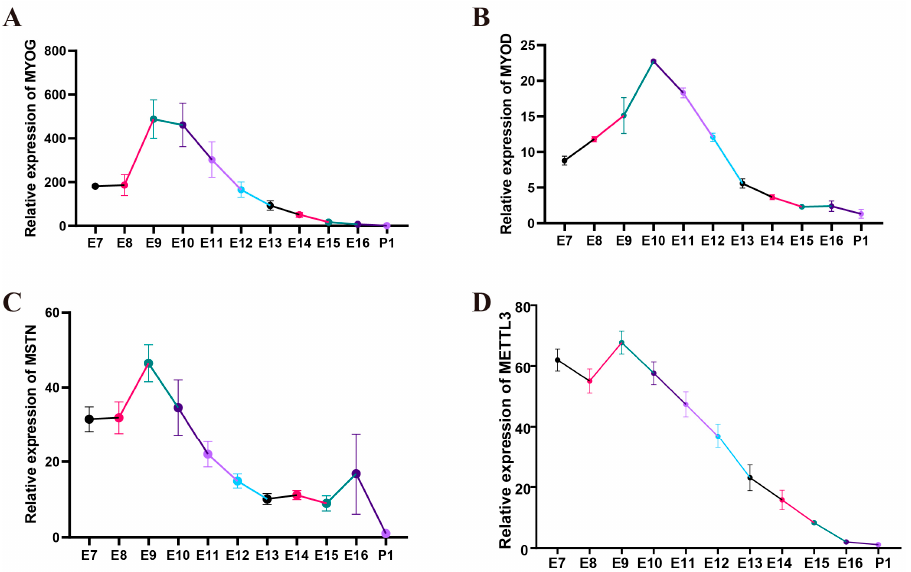
Figure 2. The spatiotemporal expression of skeletal muscle differentiation marker genes and METTL3 in quail leg muscle. ( A – D ) Spatiotemporal expression of MYOG , MYOD , MSTN , and METTL3 from E7 to P1 in leg muscle. E7–E16 represents embryonic day 7 to embryonic day 16, and P1 represents post-hatch day 1. Four female quails were used at each time point. Di ff erent colors in the fi gure indicate the di ff erent developmental stages of quail leg muscle.